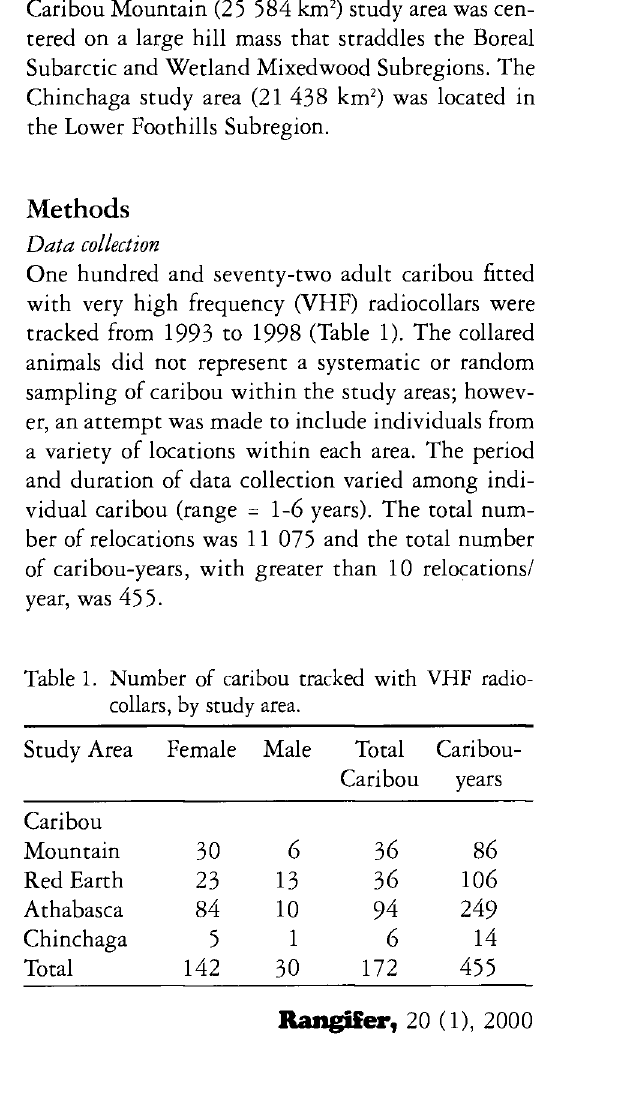
Fig. 1. Location of the four study areas in northern Alberta (open polygons). The boundaries of the three zones used in the Natural Subregion analy sis are also shown (shaded polygons; labels indi cate the dominate National Subregion in each zone).